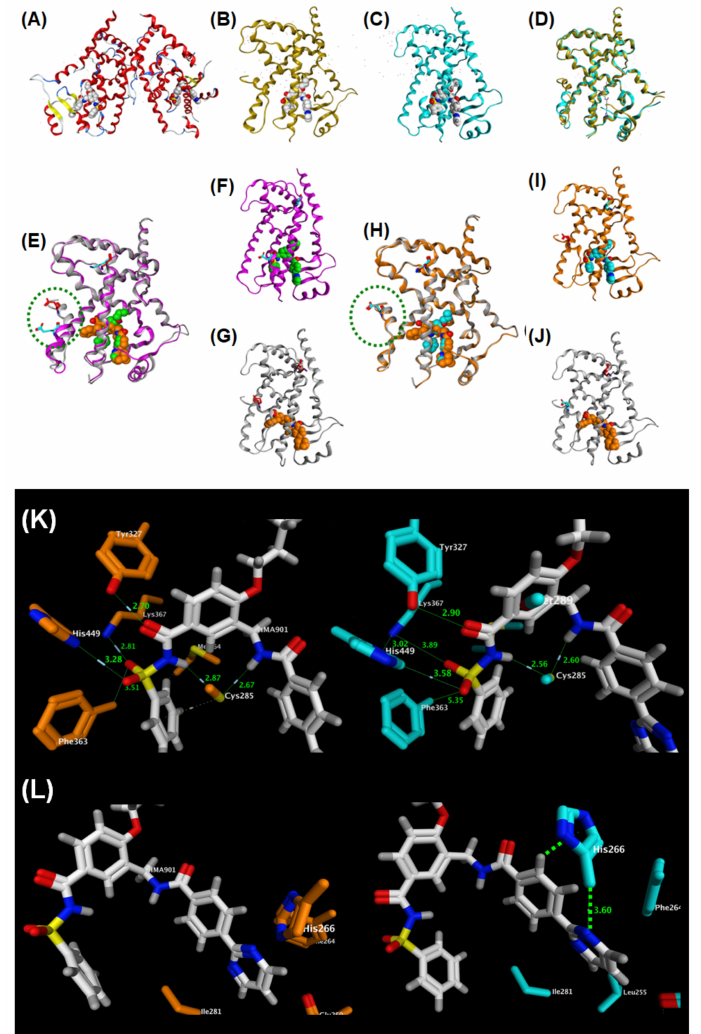
Figure 24. ( A ) Structural development of a hPPAR γ -selective partial agonist from a hPPAR γ pan agonist. ( B – E ) X-ray crystallographic structure of the homo-dimeric structure of MEKT-75 complexed with the hPPAR γ LBD. ( B ) Homo-dimeric structure of MEKT-75 complexed with the hPPAR γ LBD. ( C ) Full agonist form monomer. ( D ) Partial agonist form monomer. ( E ) Superposed structure of the homo-dimeric structure of MEKT-75 complexed with the hPPAR γ LBD. MEKT-75 was omitted. ( F ) Superposed structure of the partial agonist form MEKT-75 monomer and the TIPP-703 monomer complexed with the hPPAR γ LBD. ( G ) Partial agonist form MEKT-75 monomer. ( H ) Overall structure of TIPP-703 complexed with the hPPAR γ LBD. ( I ) Superposed structure of the full agonist form MEKT-75 monomer and the TIPP-703 monomer complexed with the hPPAR γ LBD. ( J ) Partial agonist form MEKT-75 monomer. ( K ) Overall structure of TIPP-703 complexed with the hPPAR γ LBD. ( K , L ) (left) Zoomed view of the fully active form of MEKT-75. (right) Zoomed view of the non-fully active form of